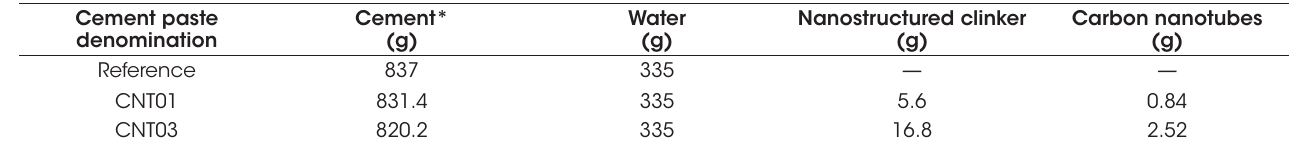
Table 2 Cement paste denomination and corresponding mix proportion used for a 0.6 − liter volume Cement paste